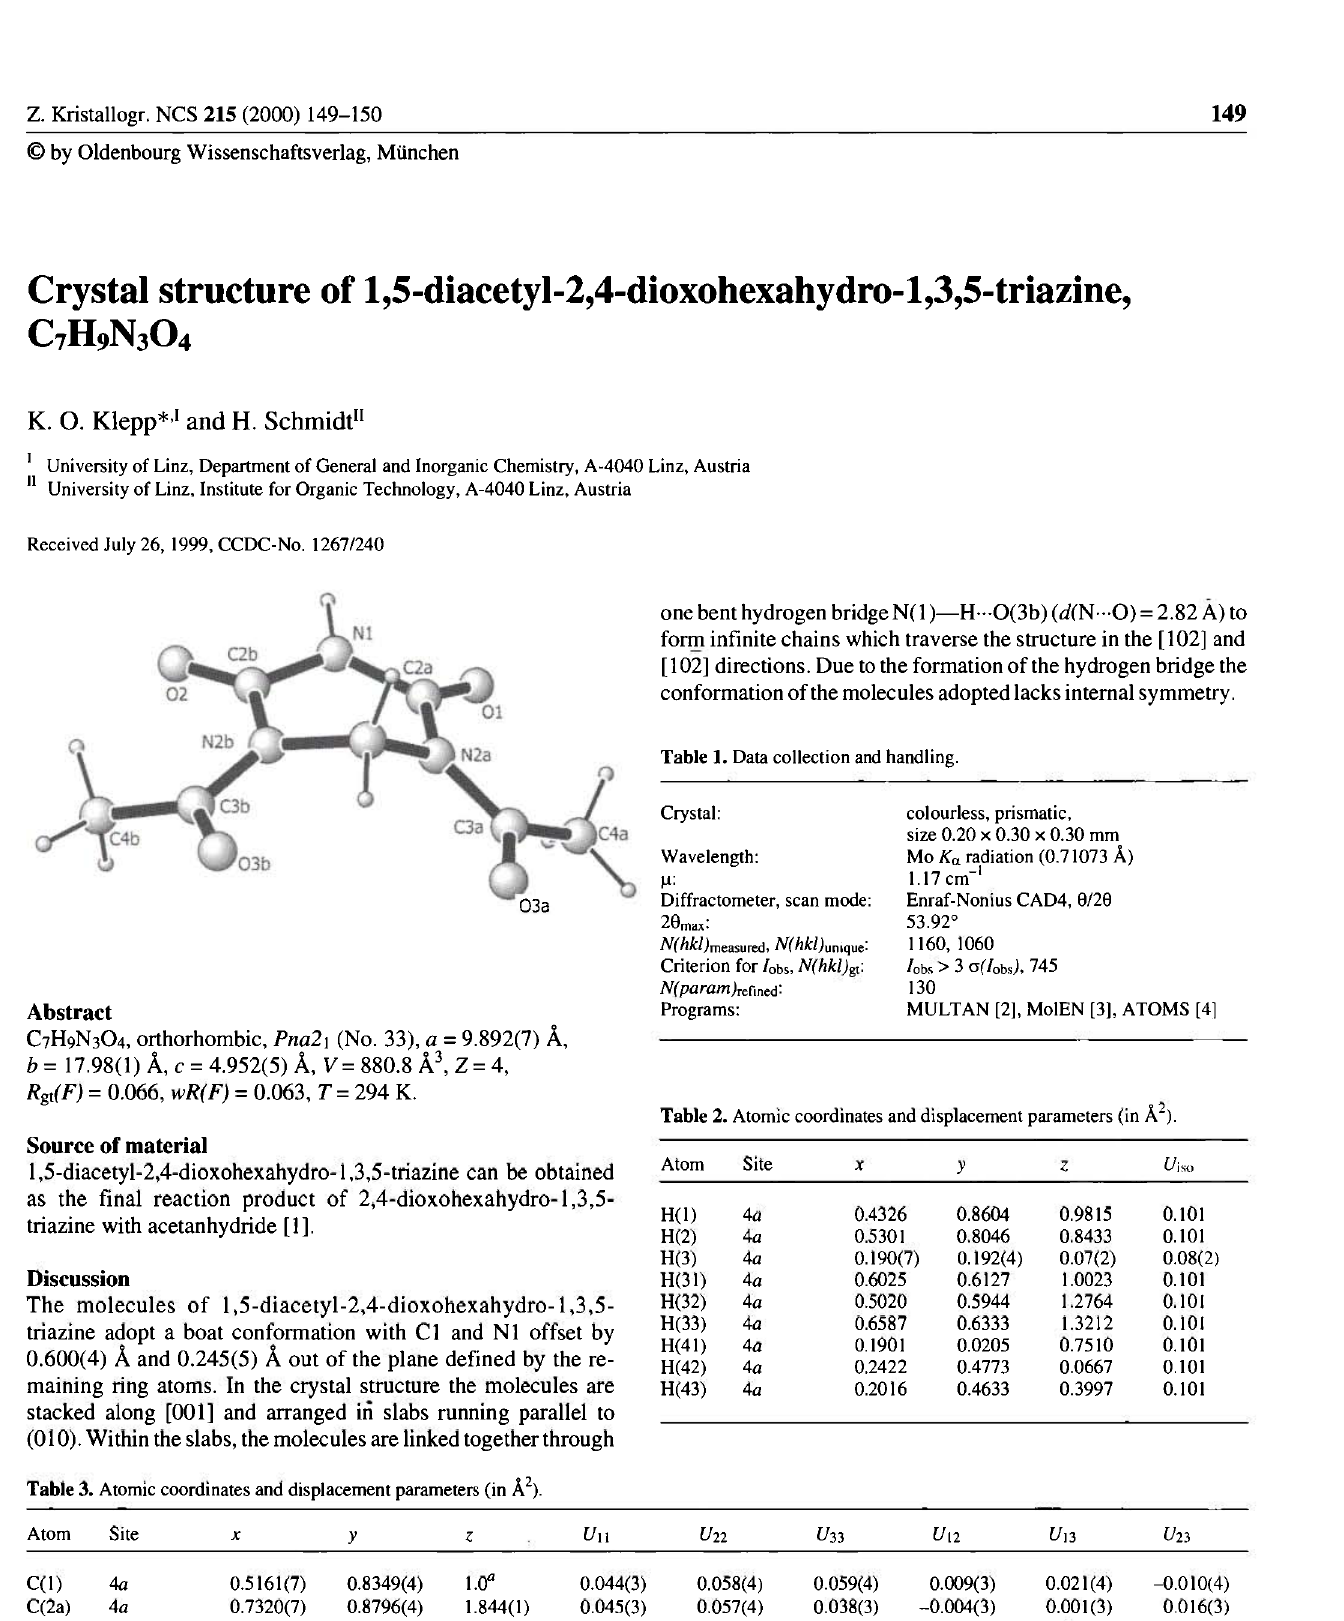
Table 3. Atomic coordinates and displacement parameters (in Ä 2 ).